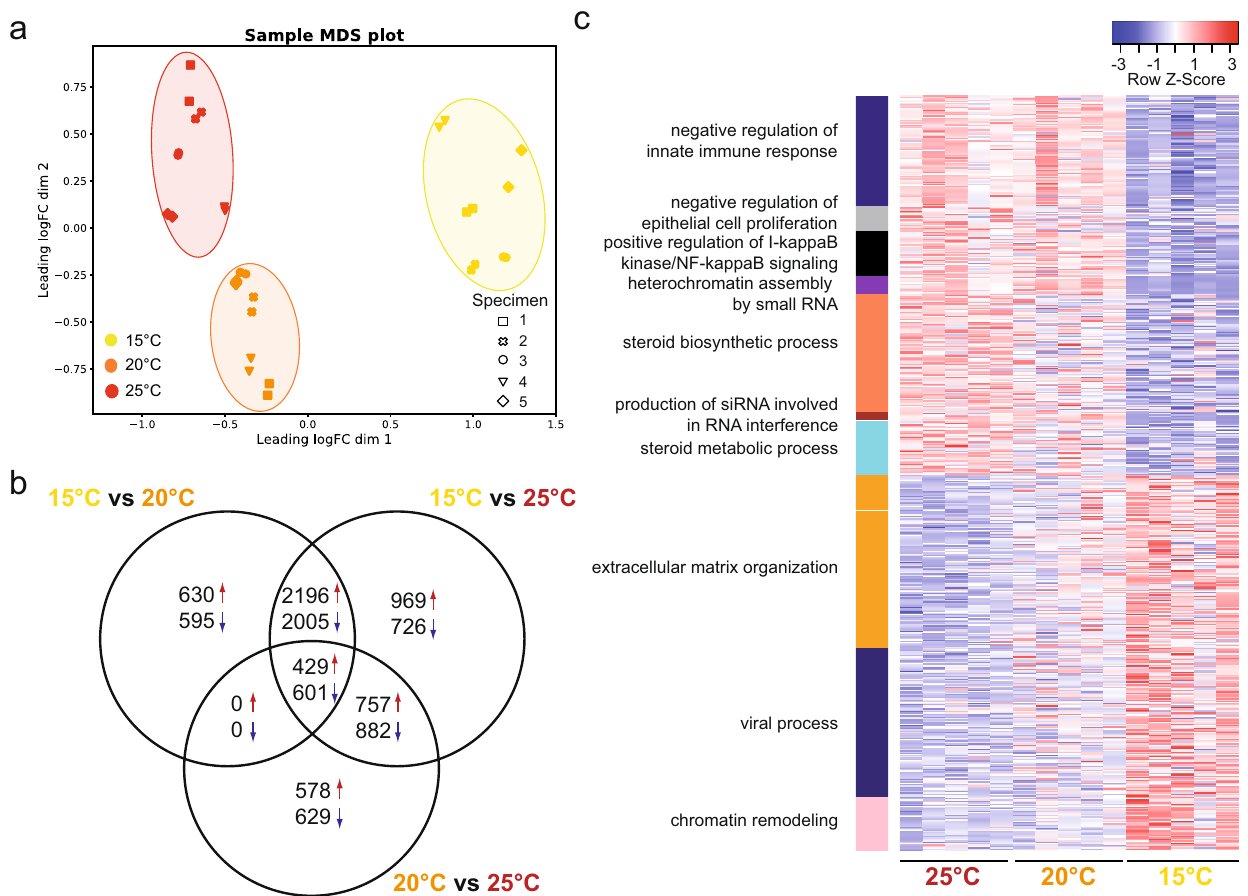
Fig. 4 Host transcriptome changes after thermal acclimation. a MDS plot showing clustering of the transcriptome pro fi les according to the AT (samples were sequenced in technical replicates, indicated by the different symbols). b Venn diagram showing the numbers of differentially expressed genes from pairwise comparisons between the three ATs. c Heat-map of differentially expressed genes in signi fi cantly enriched GO term categories from the comparison between 15 and 25 °C acclimated